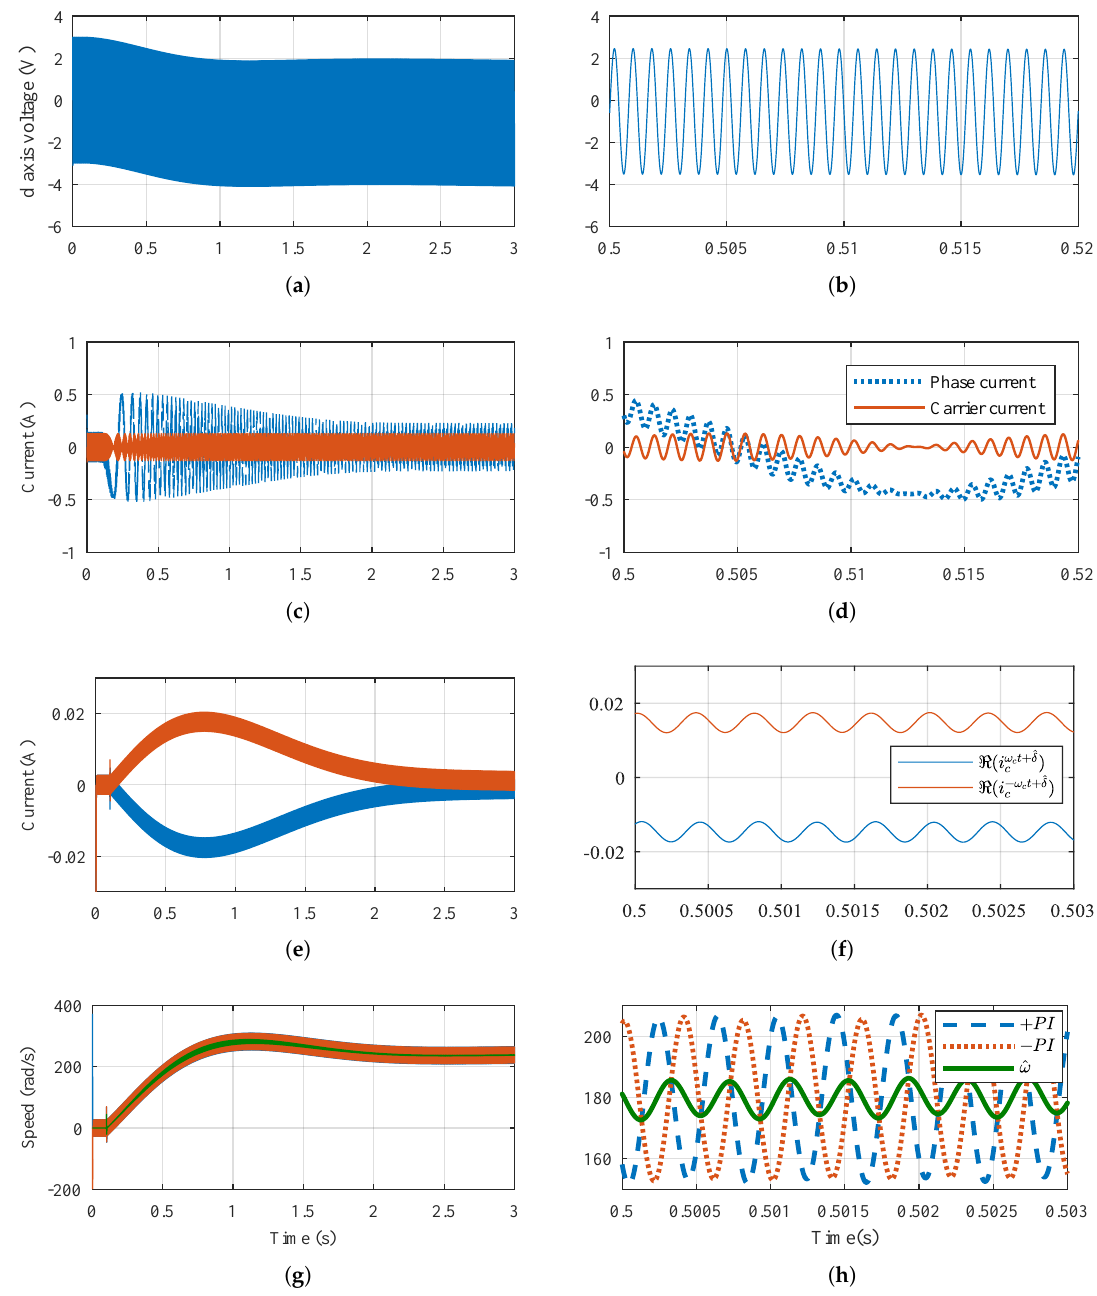
Figure 6. Simulations results for the estimation procedure of the proposed demodulation scheme. ( a ) d axis voltage reference. ( b ) Magnified waveform of ( a ). ( c ) Phase current (dotted blue) and carrier current (solid orange). ( d ) Magnified waveform of ( c ). ( e ) Real parts of the positive (blue) and negative (orange) sequences. ( f ) Magnified waveforms of ( e ). ( g ) Positive sequence (dashed blue), negative sequence (dotted orange) and composed (solid green) speeds. ( h ) Magnified waveforms of ( g